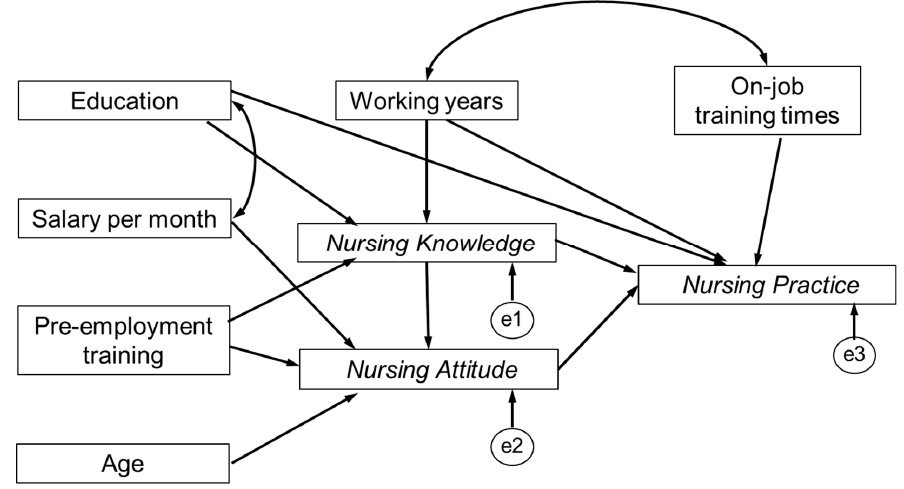
Figure 2. First-round model of knowledge, attitude, and practice regarding elderly care.